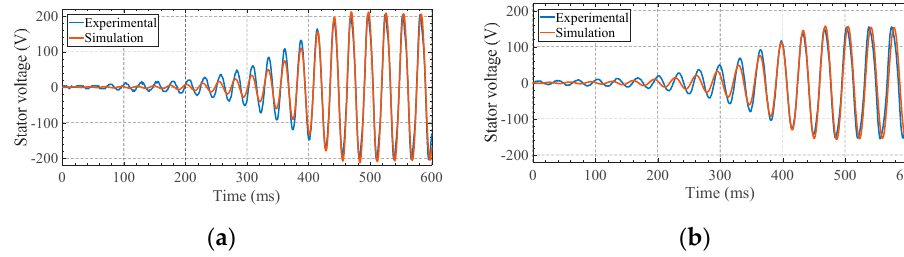
Figure 10. SEIG stator voltage during the excitation process with: ( a ) C = 50 μ F and ( b ) C = 80 μ F. In blue, the experimental results. In red, the simulation ones.